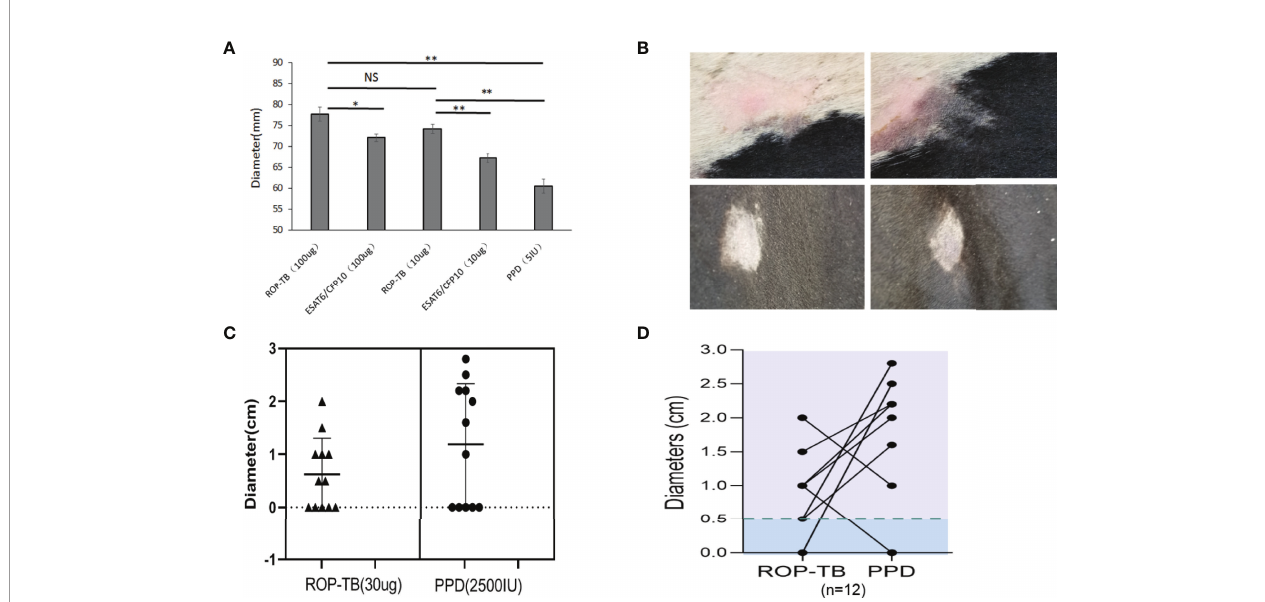
FIGURE 4 | Delayed-type hypersensitivity to ROP-TB, ESAT-6/CFP10, and PPD in Mtb infected guinea pigs and M. bovis -infected cattle. (A) Skin reaction in guinea pigs: the bars show the size of skin reaction to two doses (100 m g and 10 m g) of ROP-TB and ESAT-6/CFP-10, respectively in guinea pigs (n=4 per group). PPD at 5 IU was used as a comparison. Delayed-type hypersensitivity to ROP-TB and PPD in cattle infected with tuberculosis (n=12). (B) Skin reaction to cattle: Representative positive skin reactions to ROP-TB (upper left panel) and PPD (upper right panel); and negative reactions to ROP-TB (lower left panel) and PPD (lower right panel). (C) The size of the skin reactions of all 12 cattle to ROP-TB (left panel) and PPD (right panel). (D) The relationship of DTH of each head of cattle to ROP-TB and PPD. “ * ” (P<0.05): signi fi cant difference, “ ** ” (P<0.01): extremely signi fi cant difference. NS; no statistically signi fi cant